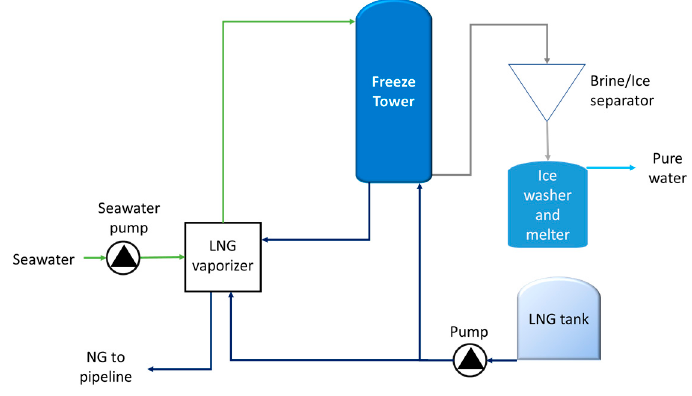
Figure 5. Diagram of FD process utilizing LNG cold energy [21].